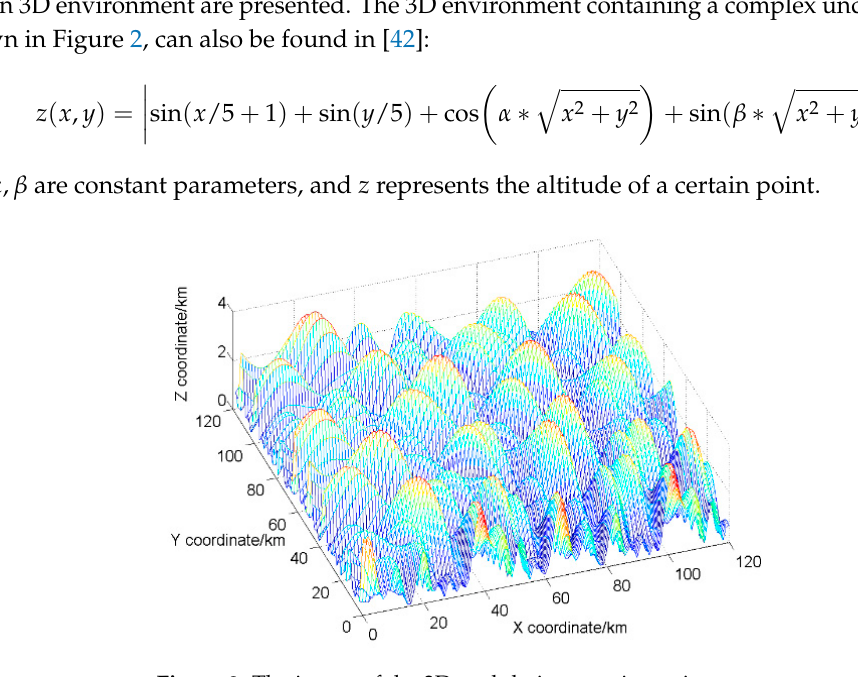
Table 1. The parameters used in experiments of different algorithms.